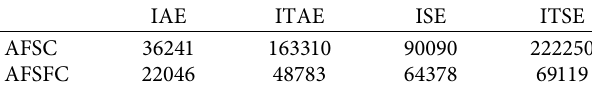
Table 2: Performance comparisons (fault